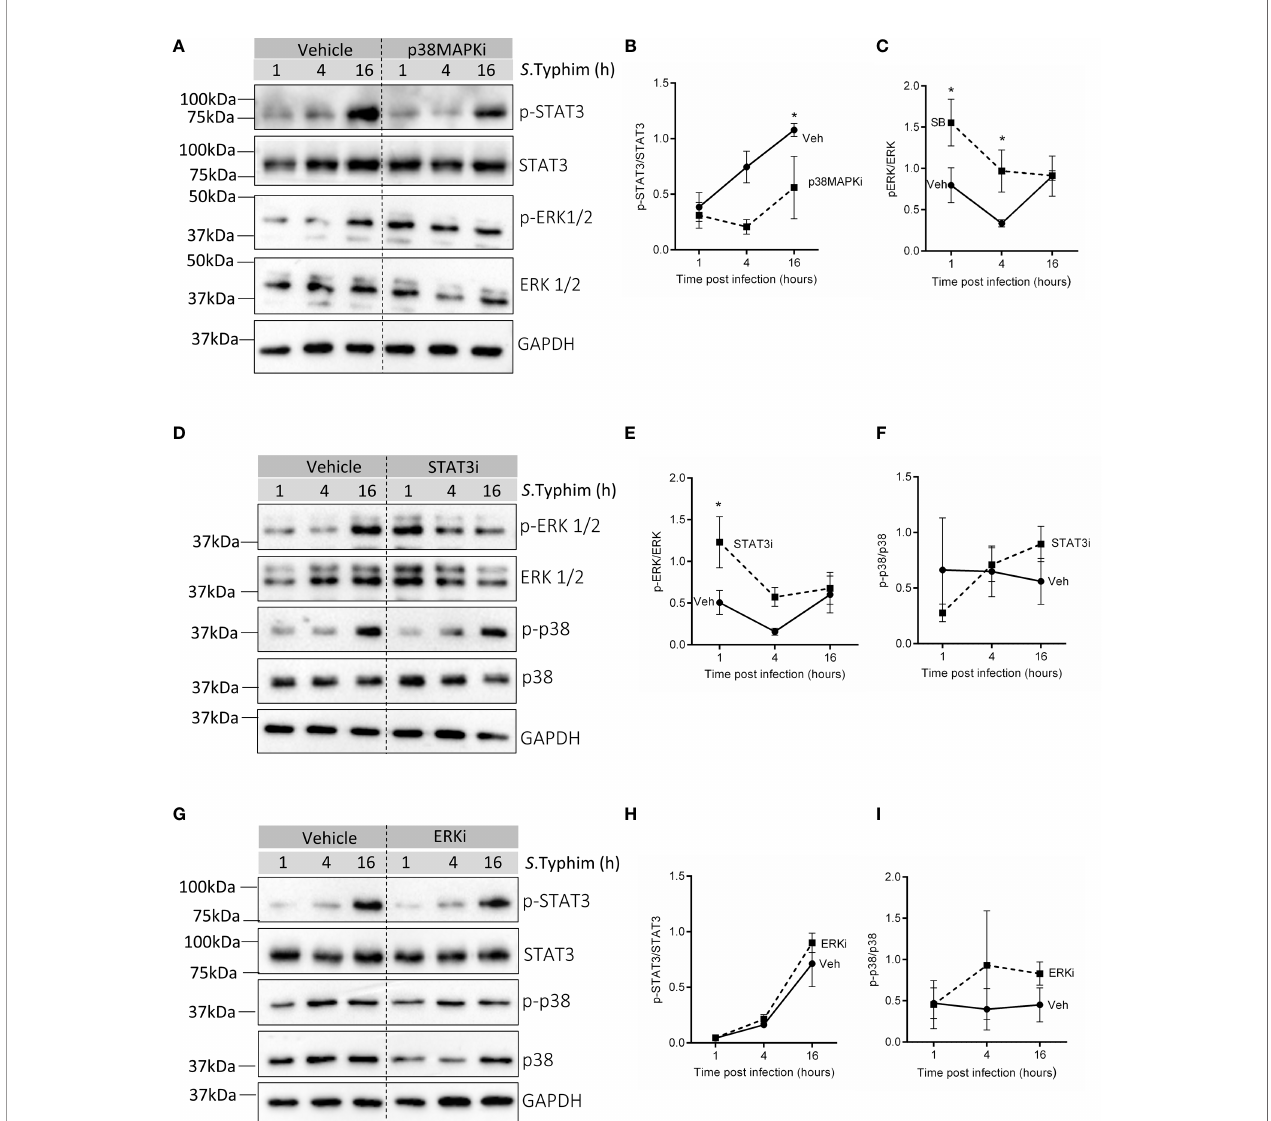
FIGURE 3 | Probing crosstalk of p38 MAPK, ERK and STAT3 in infected senescent cells. (A) Western blot for phosphorylated and total levels of STAT3 and ERK1/ 2 in vehicle or p38MAPKi treated senescent HeLa cells at 1,4 and 16h post-infection. (B, C) Quanti fi cation of phosphorylated levels of STAT3 and ERK1/2 relative to their total levels, respectively in vehicle or p38MAPKi treated senescent HeLa cells at 1,4 and 16h post-infection. (D) Western blot for phosphorylated and total levels of ERK1/2 and p38 MAPK in vehicle or STAT3i treated senescent HeLa cells at 1,4 and 16h post-infection. (E, F) Quanti fi cation of phosphorylated levels of ERK1/2 and p38 MAPK relative to their total levels, respectively in vehicle or STAT3i treated senescent HeLa cells at 1,4 and 16h post-infection. (G) Western blot for phosphorylated and total levels of STAT3 and p38 MAPK in vehicle or ERKi treated senescent HeLa cells at 1,4 and 16h post-infection. (H, I) Quanti fi cation of phosphorylated levels of STAT3 and p38 MAPK relative to their total levels, respectively in vehicle or ERKi treated senescent HeLa cells at 1,4 and 16h post- infection. In all experiments, GAPDH was used as loading control. The data represents mean ± SEM from atleast three independent experiments. Statistical signi fi cance of differences was analysed by Two-way ANOVA followed by posthoc Fisher ’ s LSD test, * P ≤